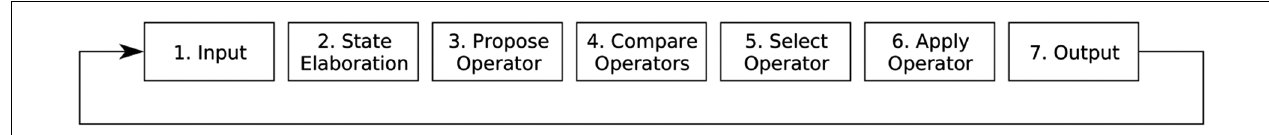
FIGURE 2 |The Soar dynamic decision cycle.